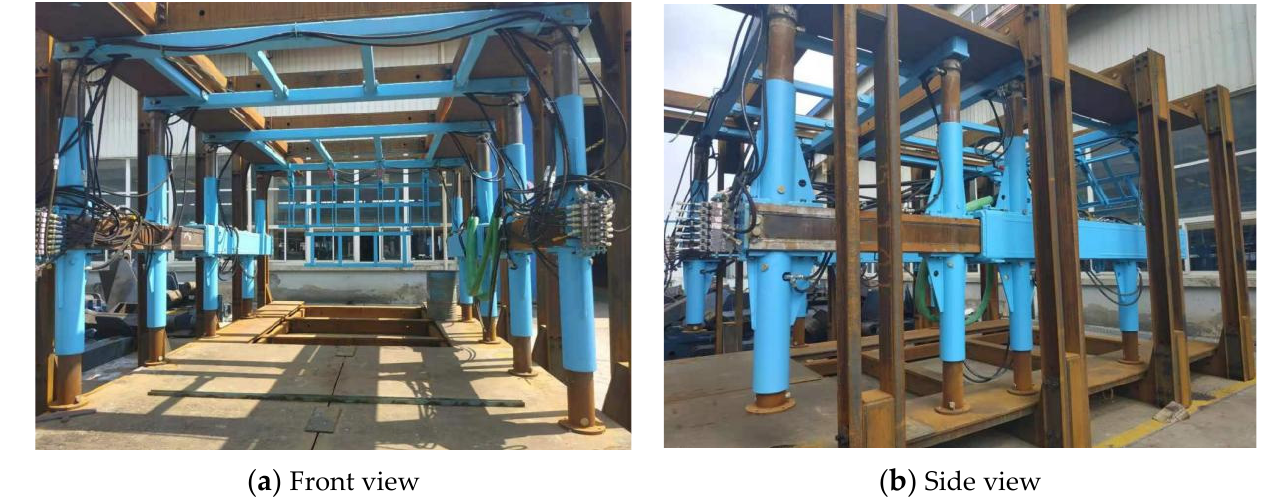
Figure 1. Schematic diagram of the new type of HAAS for fully mechanized roadways.